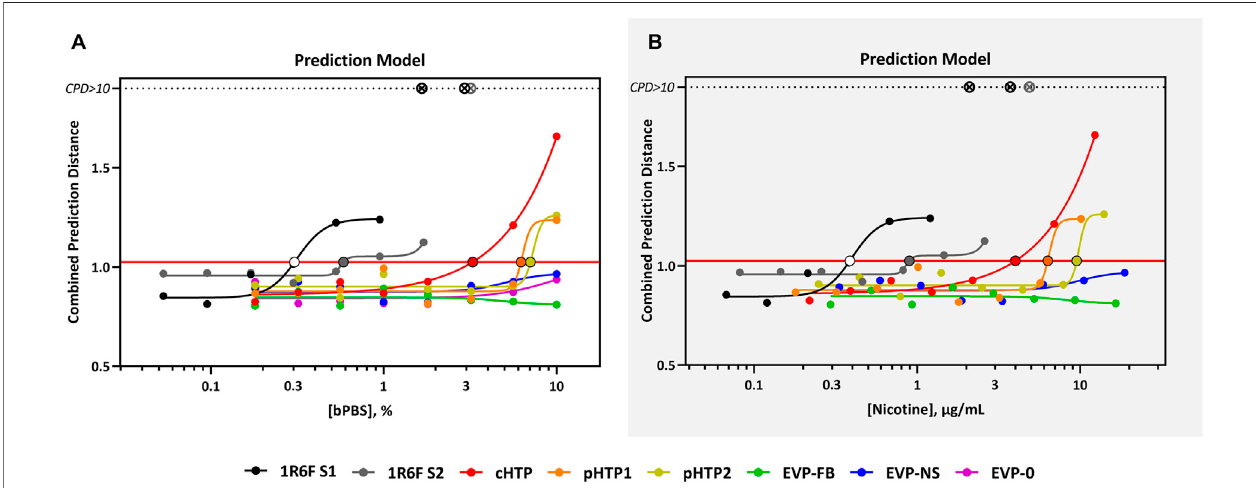
FIGURE2 | Cardio qP Prediction Model Response Comparison. The horizontalred linerepresents the cardiotoxicity threshold and theblack-bordered, fi lled circles indicate the predicted cardiotoxicity potential concentration (cTP) for each treatment. The x-axis is the concentration (% bPBS) of the test article (A) or nicotine (µg/mL) (B) . The y-axis is the combined prediction distance, which is determined from each biomarker ratio ’ s response normalized to its predictive threshold (level of change required for a toxic prediction). CPD: Combined prediction distance; ⊗ : CPD > 10.